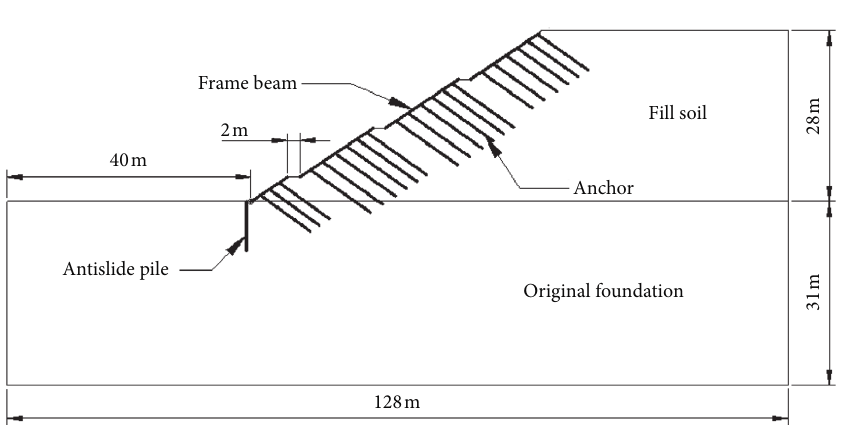
Figure 1: The diagram of multistage fill slope with frame beam and anchor reinforced.